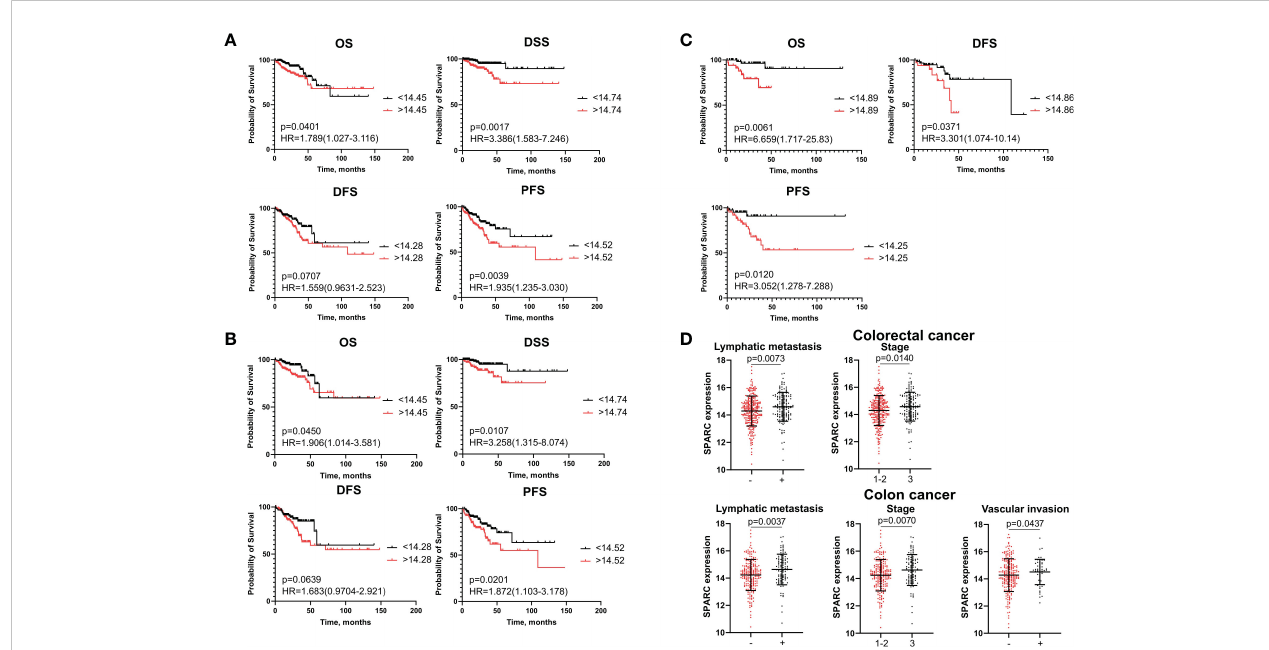
FIGURE 2 SPARC mRNA expression is associated with survival and clinical-pathological parameters. (A) Kaplan – Meier curve of TCGA survival data (OS, DSS, DFS, and PFS) for high-risk and low-risk patients in combined CRC group. (B) Kaplan – Meier curve of TCGA survival data for high-risk and low-risk groups in colon cancer patients. (C) Kaplan – Meier curve of TCGA survival data for high-risk and low-risk groups in rectal cancer patients. Log-rank test p-values are shown in Kaplan – Meier curves. (D) SPARC mRNA expression is associated with lymph node metastasis and tumor stage in CRC patients, and with lymph node metastasis, stage and vascular invasion in colon cancer patients. Student ’ s t-test was applied. Scatter plots depict gene expression as mean with